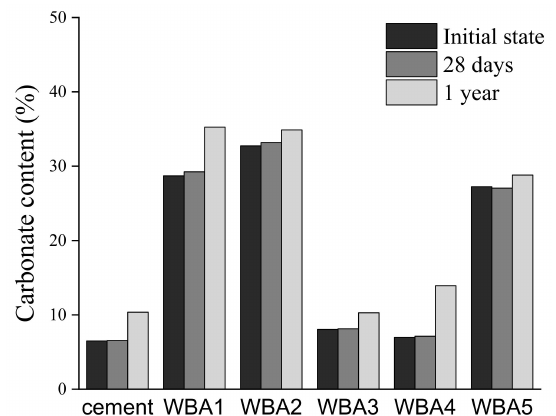
Figure 4. Carbonate content for WBA samples and cement per time according to equation